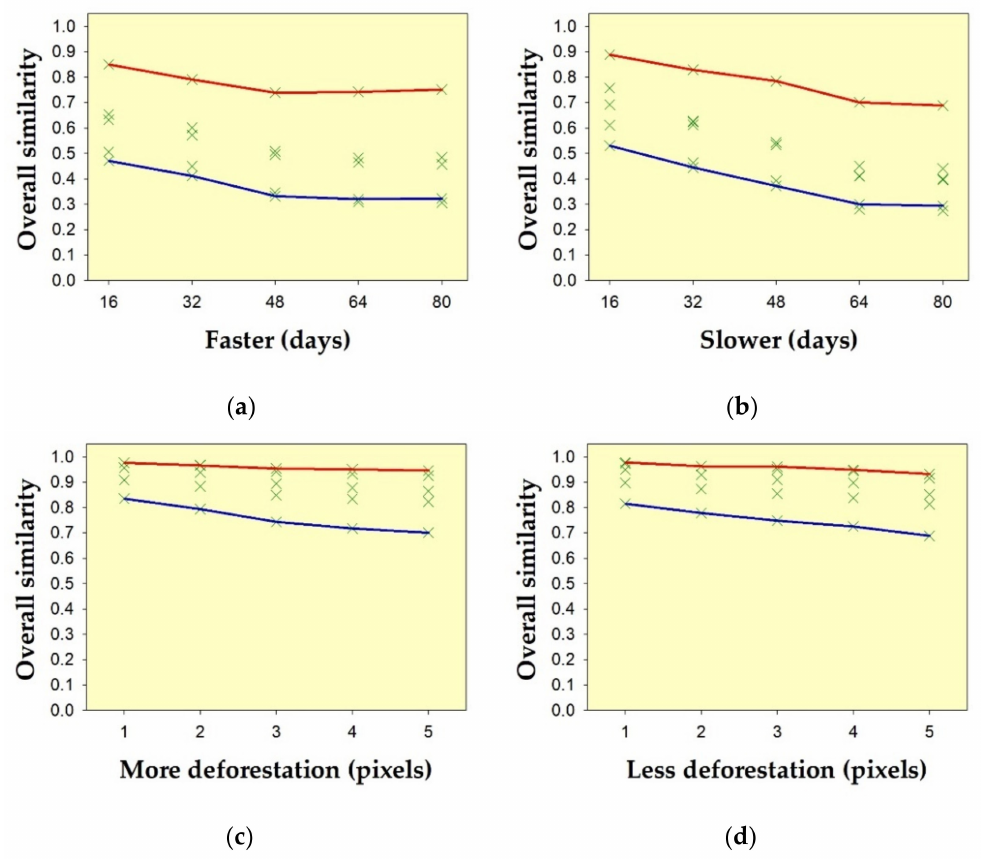
Figure 22. Sensitivity of the method on hypothetical temporal data sets on deforestation after inter- polation at a time slice of 1 day, due to the possibility of ( a ) acceleration, ( b ) delay, ( c ) overestimation, and ( d ) underestimation of deforestation detection, compared to the reference. Green crosses indicate overall similarity (i.e., the average of θ and δ similarities) from all nine metrics. Red lines on the upper edge of the envelopes indicate the overall similarity using the Fidelity metric. Blue lines on the lower edge of the envelopes indicate the overall similarity using the metric of